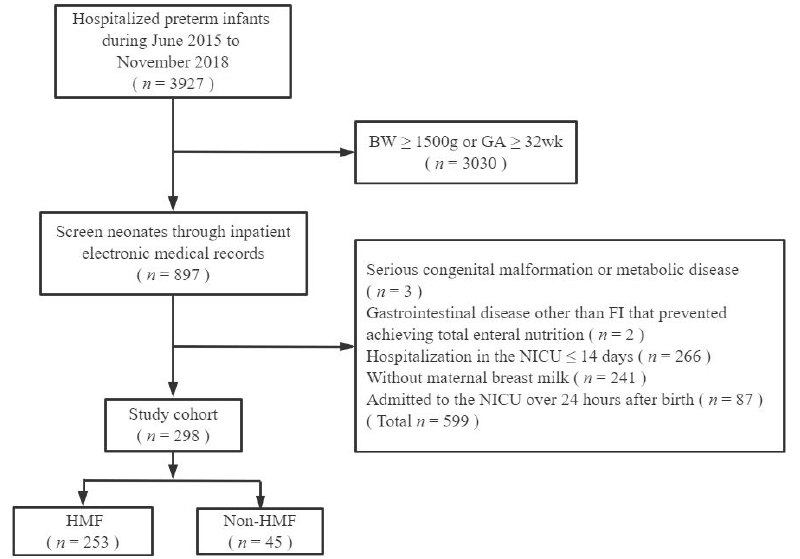
Figure 1. Patient flow diagram. BW, birth weight; FI, feeding intolerance; GA, gestational age; HMF, human milk fortifier; NICU, neonatal intensive care unit.